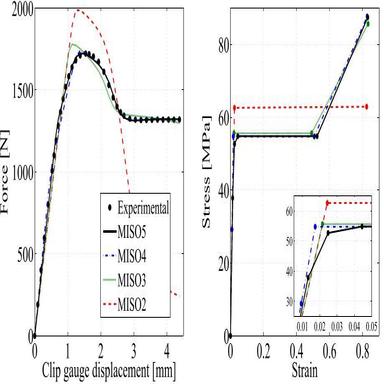
Force and stress–strain responses from the multilinear models.